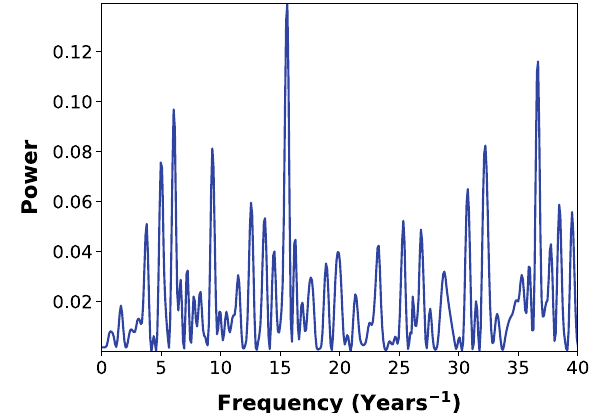
Fig. 1 Half-life time-series (along with error bars) for 123 I using the data from B18. The dashed horizontal lines indicate the ± 1 σ range for the data